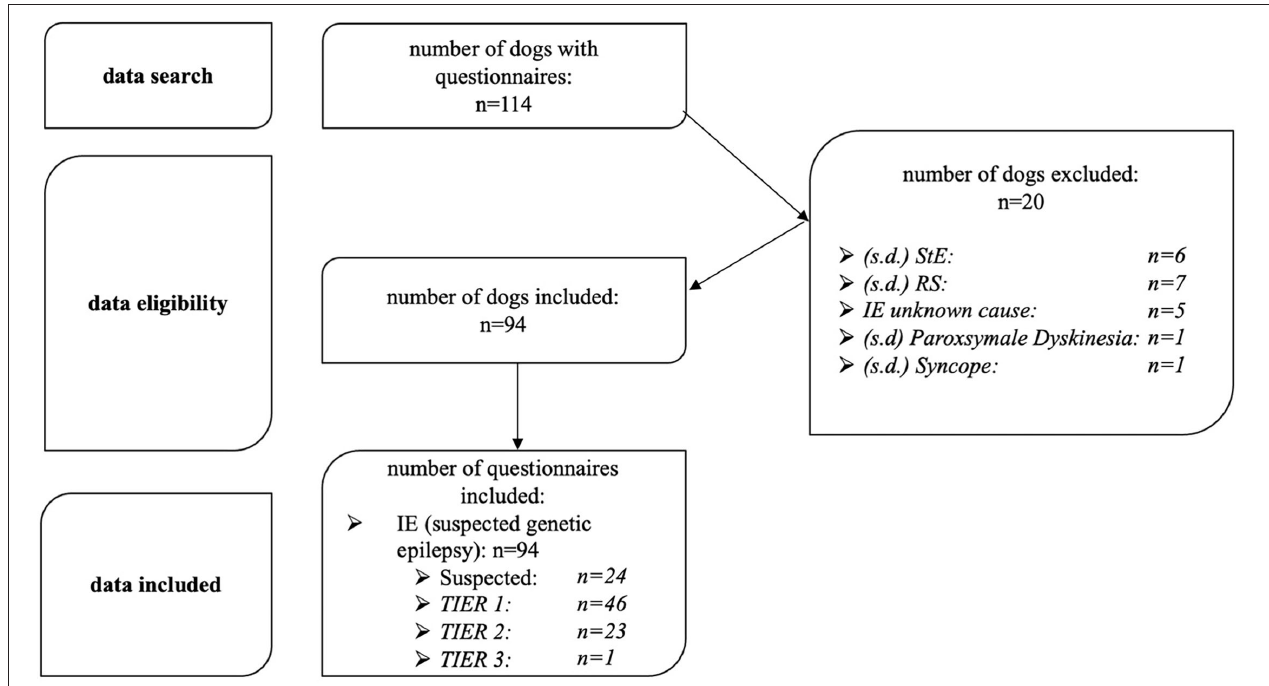
FIGURE 1 | Study protocol for data analysis, inclusion and exclusion criteria. n, number of dogs; StE, structural epilepsy; IE, idiopathic epilepsy; suspected, suspected idiopathic epilepsy; TIER, confidence level (TIER 1,2,3); RS, reactive seizures; s.d., suspected diagnosis.